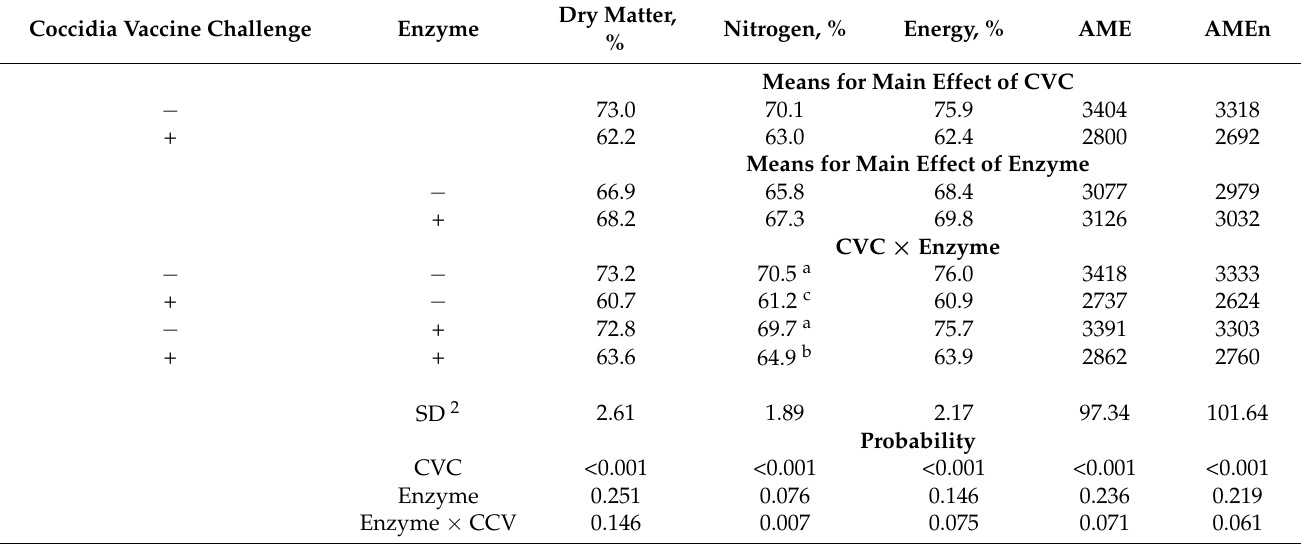
Table 3. Main and simple effects of coccidia vaccine challenge (CVC) and exogenous enzyme supplementation on nutrient and energy retention, apparent metabolizable energy (AME), and apparent metabolizable energy corrected for nitrogen (AMEn) in 21-day-old broiler chickens fed corn-soybean meal-based diets (7-day post-challenge) 1 . Coccidia Vaccine Challenge